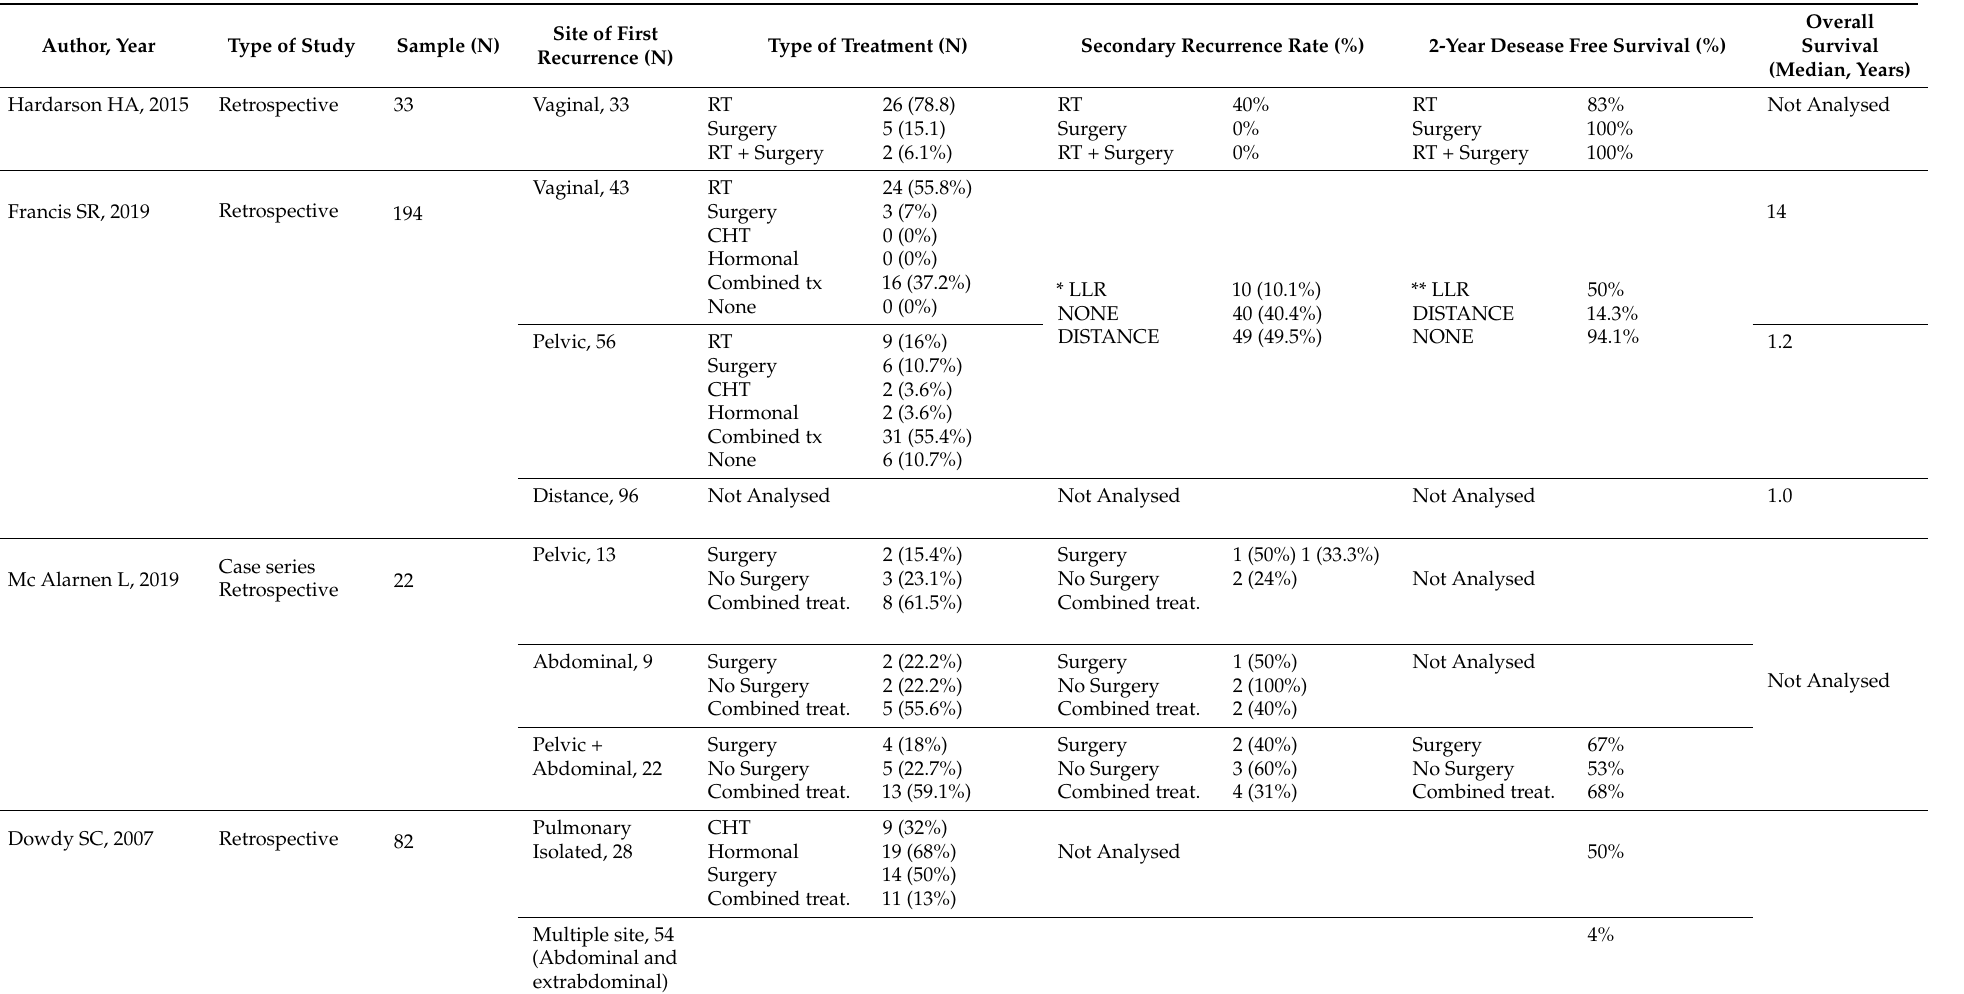
Table 1. Characteristics of the